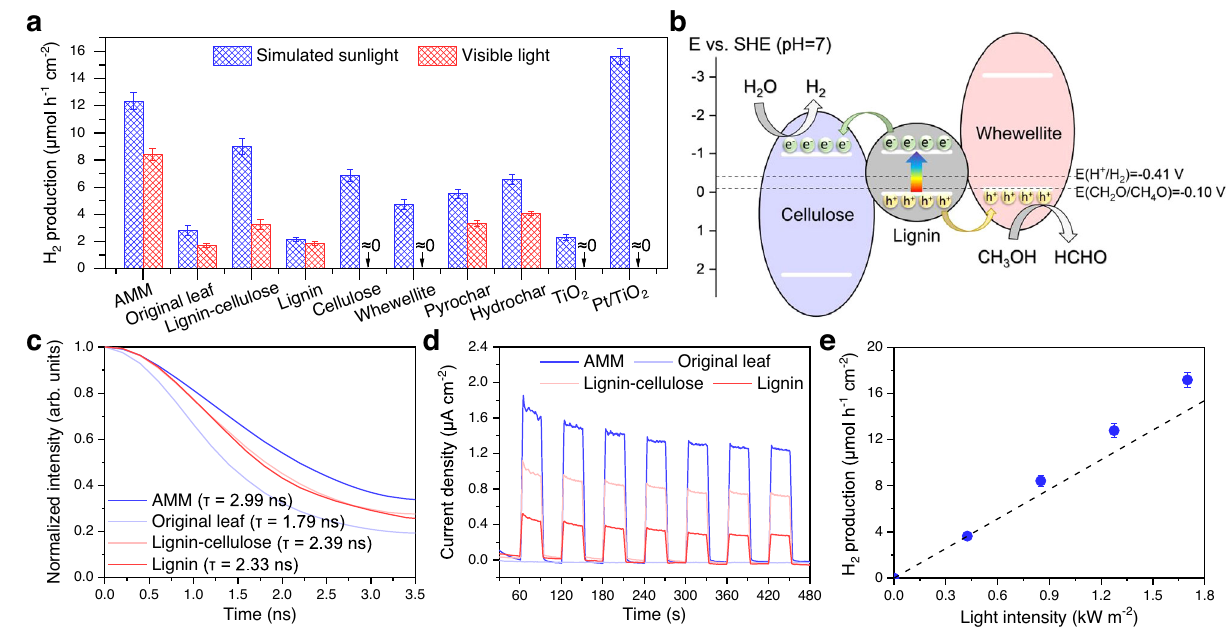
Fig. 5 | Application of the AMM fi lm for photocatalytic hydrogen production and analysis of charge carrier behaviors. a Photocatalytic hydrogen production from a methanol-watermixtureunder simulatedsunlight (1kWm − 2 ) or visible light ( λ >400nm,0.85kWm − 2 ). b SchematicbandstructureoftheAMMandvisible-light